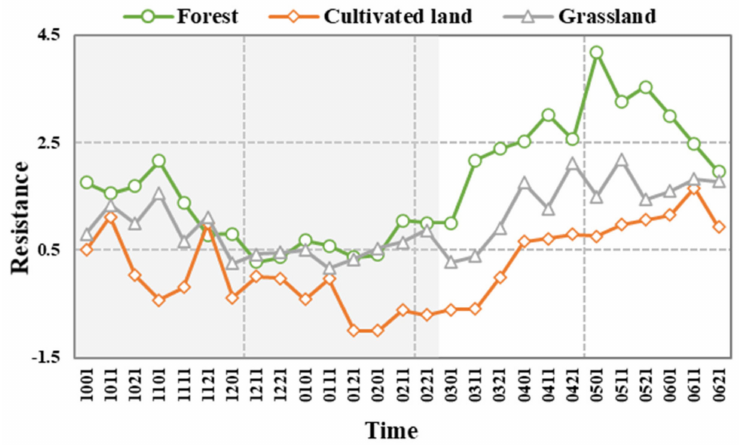
Figure 4. Temporal variation of drought resistance in three different vegetation types (forest, cul- tivated land, grassland) from October 2010 to June 2011. Time is expressed as month, day (i.e., 1001 − 1 October 2010; 0621 − 21 June 2011). Shading area indicates the period of drought. Droughts started in early October (1001), reached a peak in early February (0201) and began to ease in late February